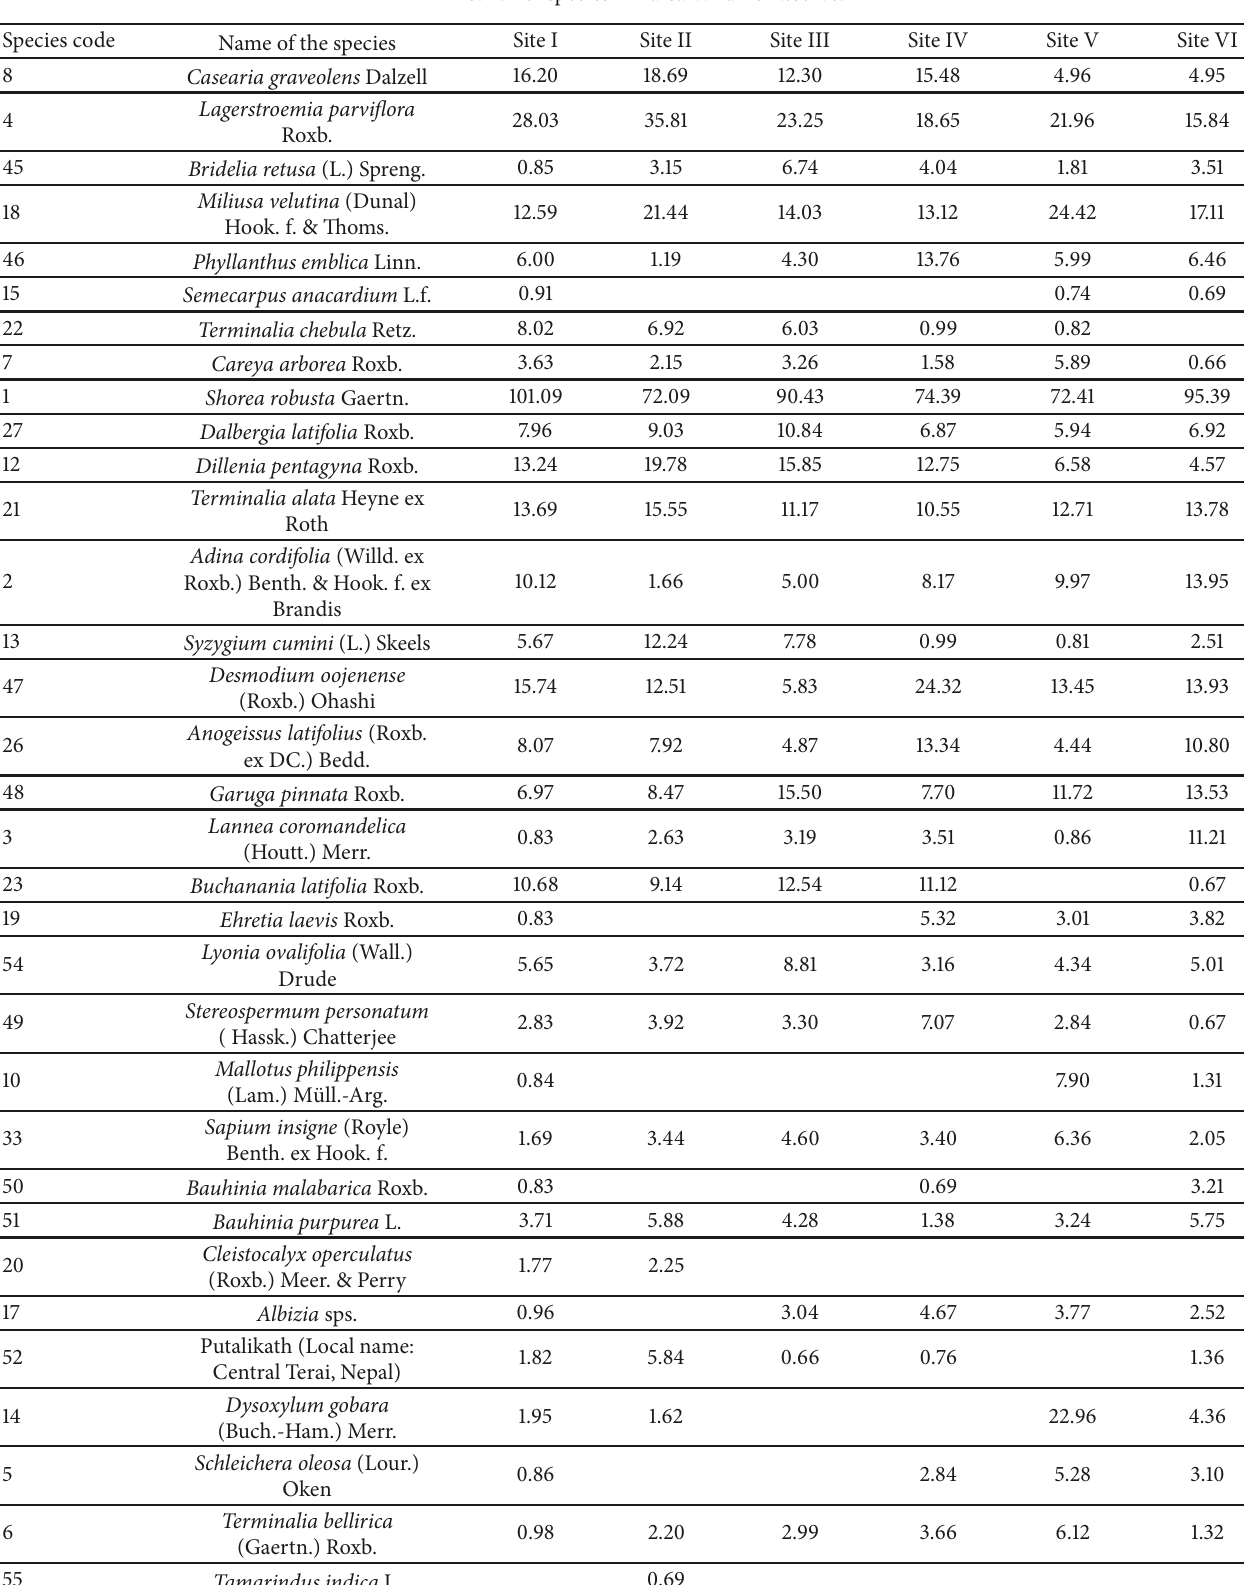
Table 10: IVI of species in Parsa Wildlife